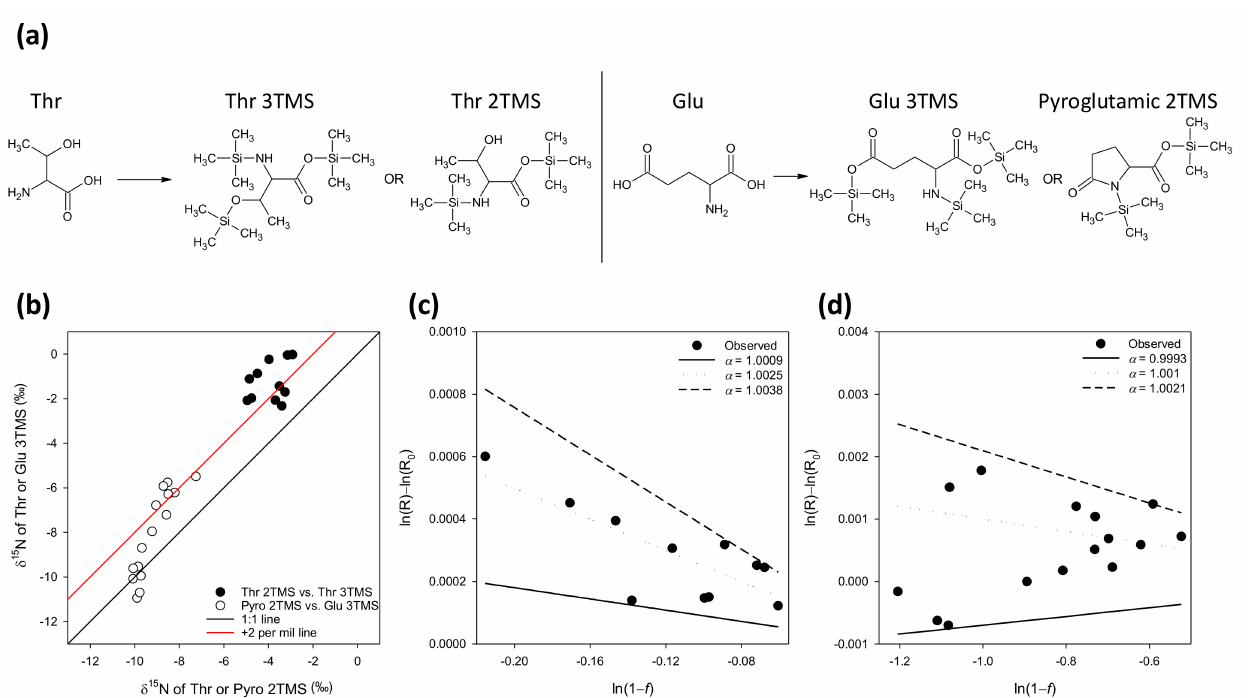
Figure 3. 14 N/ 15 N kinetic isotope effects in by-products formation during Thr and Glu derivati- zation. ( a ) Product considered here: Thr with 2 or 3 TMS groups, and Glu 3TMS or pyroglutamate 2TMS production. ( b ) Relationship between δ 15 N values of products, showing the isotopic offset of roughly 2 per mil on average between products. ( c ) Calculation of the apparent isotope effect in “pyroglutamatization” of Glu 3TMS, using a log-log plot. ( d ) Calculation of the apparent isotope effect in the loss of a TMS group from Thr 3TMS, using a log-log plot (Rayleigh fractionation plot). The isotope effect for modelled lines ( α ) refers to the 14 N/ 15 N ratio of rates. The principle of Rayleigh’s equation is recalled in Section